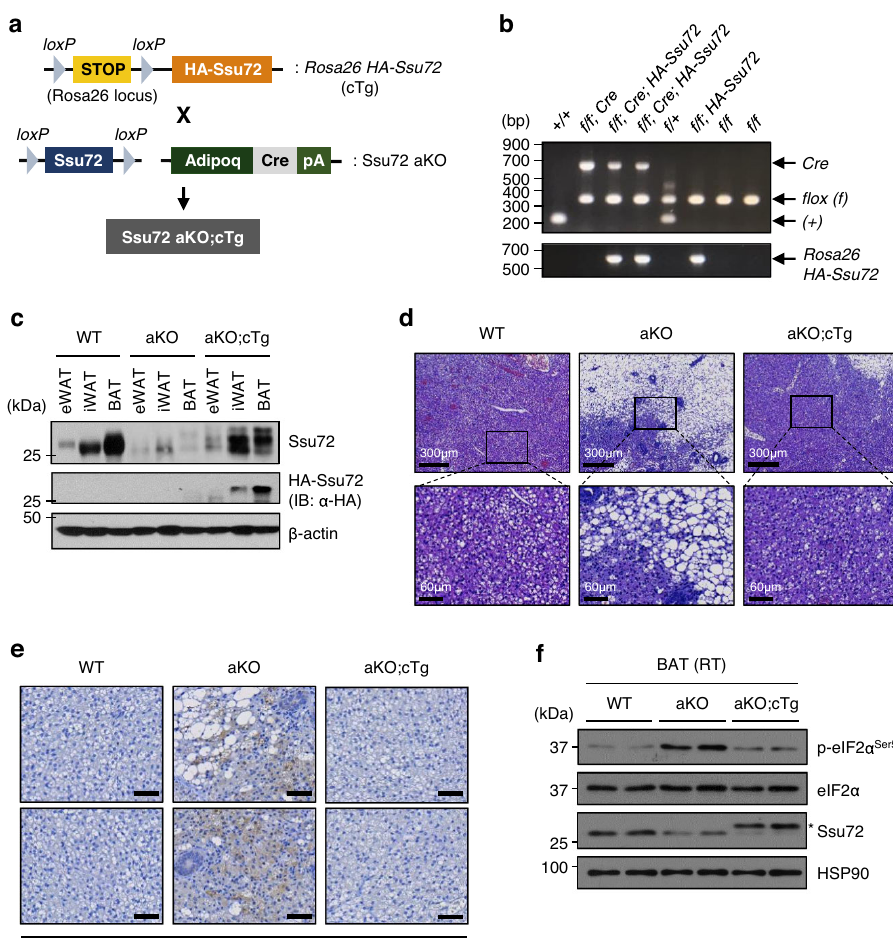
Fig. 5 | Ectopic Ssu72 expression in adipose tissue restores morphological alteration of Ssu72-de fi cient BAT and reduces eIF2 α phosphorylation in vivo. a Schematic strategy for generating Adiponectin-Cre ; Ssu72 fl ox/ fl ox ; Rosa26 HA-Ssu72 (Ssu72 aKO;cTg) conditional transgenic (cTg) mice. b PCR analysis with genomic DNA from mouse tail containing fl oxed ( f ), Adiponectin-Cre ( Cre ), and Rosa26 HA- Ssu72 loci( n = 4 – 5pergroup,biologicallyindependentsamples). c BATextractsof 6-week-old WT,aKO and aKO;cTg mice were immunoblotted with anti-Ssu72,anti- HA (ectopic HA-Ssu72), and anti-GAPDH antibodies ( n = 4 per group, biologically